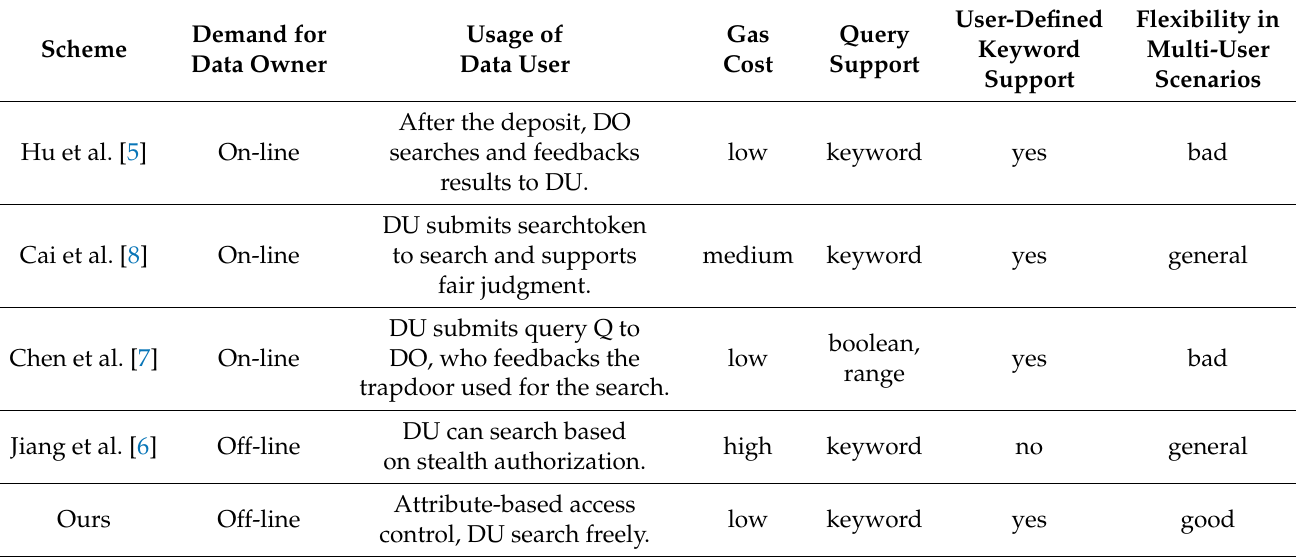
Table 1. Characteristics of all similar work and